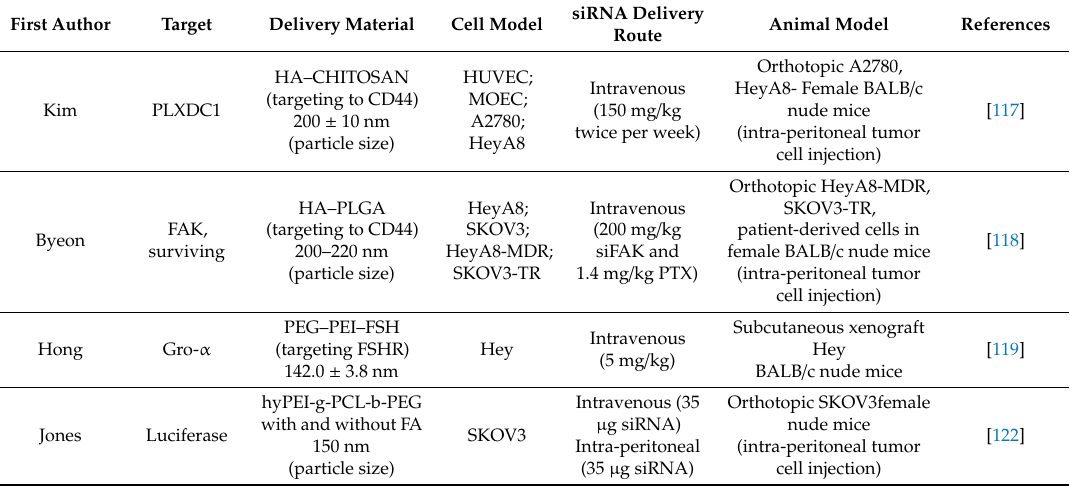
Table 6. Polymer based delivery systems with an OC-targeting